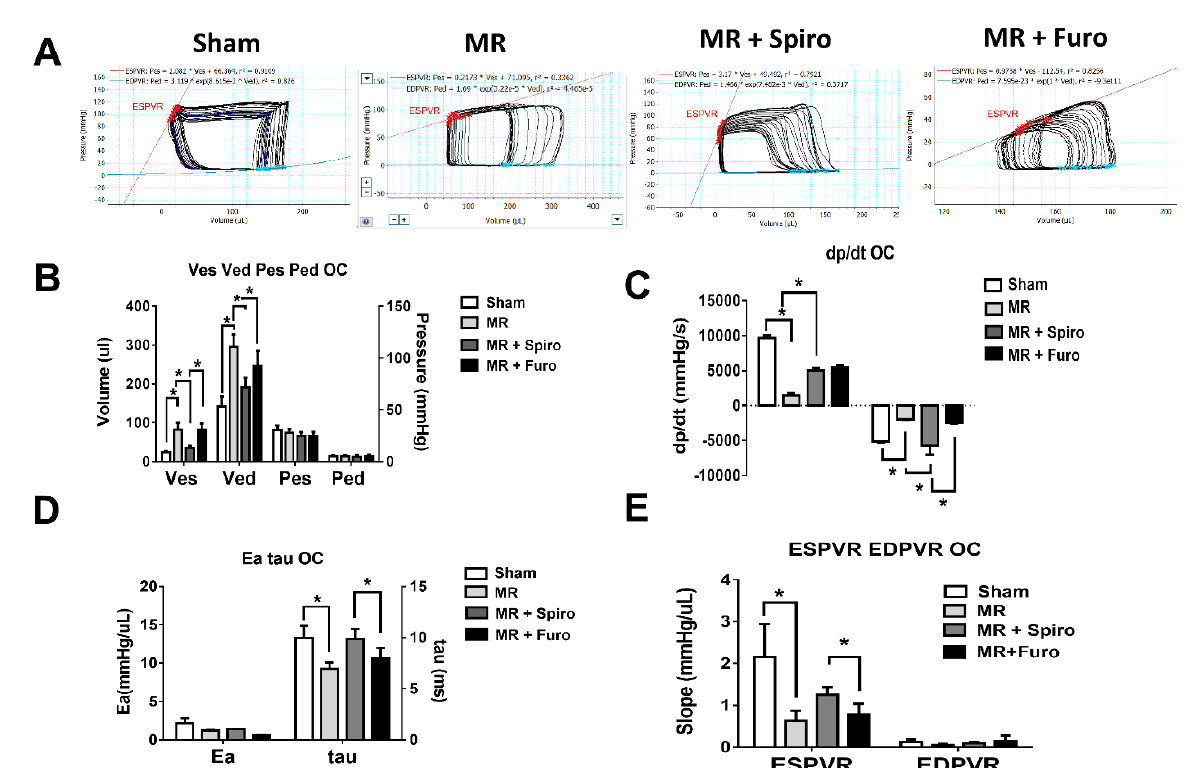
Figure 2. Effects of mineralocorticoid receptor antagonists on cardiac hemodynamics in a rat model of mitral regurgitation (MR). ( A ) Representative pressure–volume plots in the sham, MR, MR+Spiro, and MR+Furo groups. ( B ) Comparison of the mean end-systolic volume (Ves), end-diastolic volume (Ved), end-systolic pressure (Pes), and end-diastolic pressure (Ped); ( C ) maximal velocity of pressure rise (+dP/dt) and fall ( − dP/dt); ( D ) mean arterial elastance (Ea), the time constant of isovolumic pressure decay (tau); and ( E ) mean slopes of the end-systolic pressure–volume relationship (ESPVR) and end-diastolic pressure–volume relationship (EDPVR) in each group. * p < 0.05 for differences from each group.